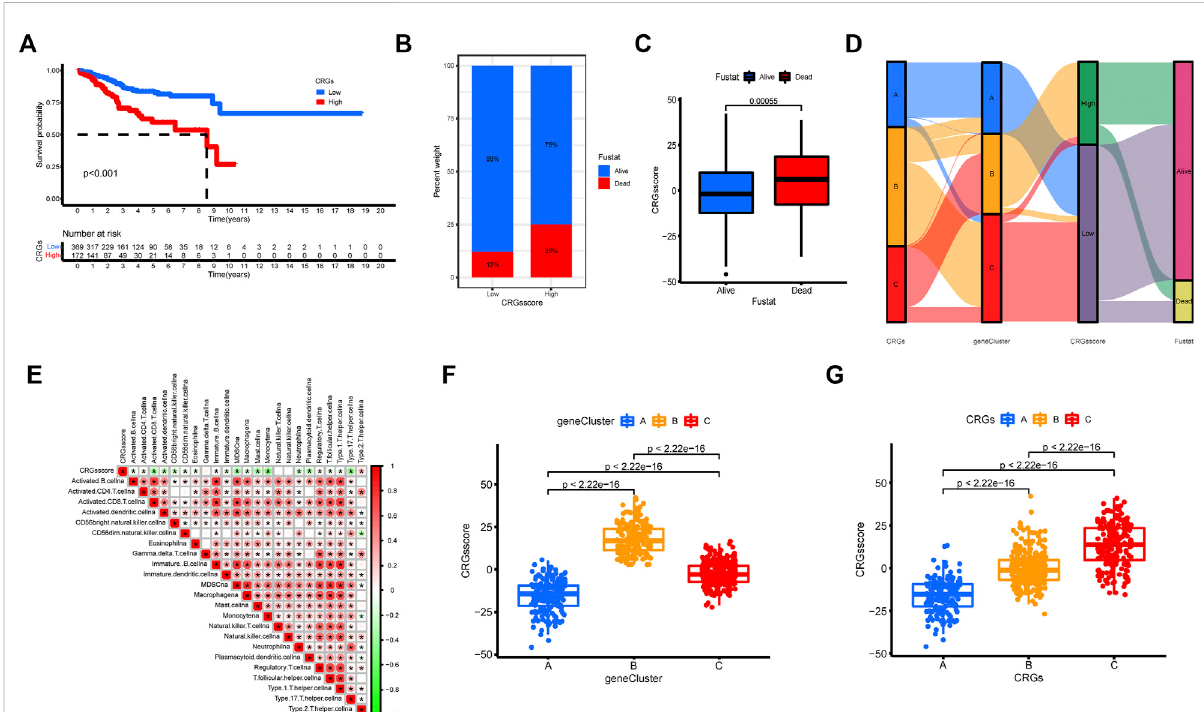
FIGURE 6 Characteristicsof CRGsscore. (A) Kaplan – Meier survival analyses for theOS inhigh and lowCRGs score groups. (B) The percentageofpatients in low and high CRGs score groups with various survival statuses. (C) The variation of CRGs score between the alive and dead group. (D) The alluvial diagram showed the relationship between CRGs cluster, gene cluster, CRGs score, and survival status. (E) Spearman analysis of the correlations between CRGs score and in fi ltrating immune cells. Red means the positive correlation and green means the negative correlation. The asterisk represents p -value that is meaningful statistically. (F,G) Differential analysis of CRGs score among (F) three CRGs gene clusters and (G) three CRGs clusters ( p <